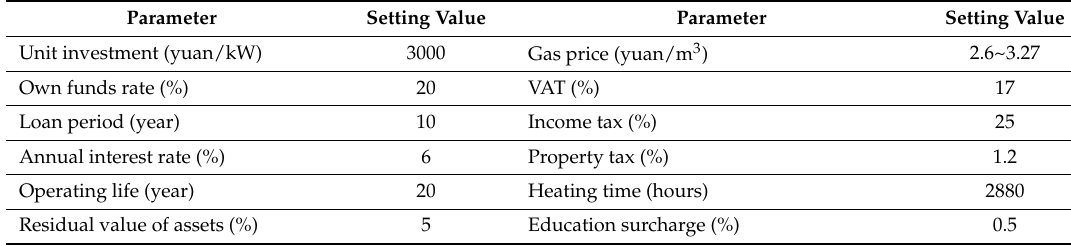
Table 6. Related parameters of centralized NGPG projects (peak